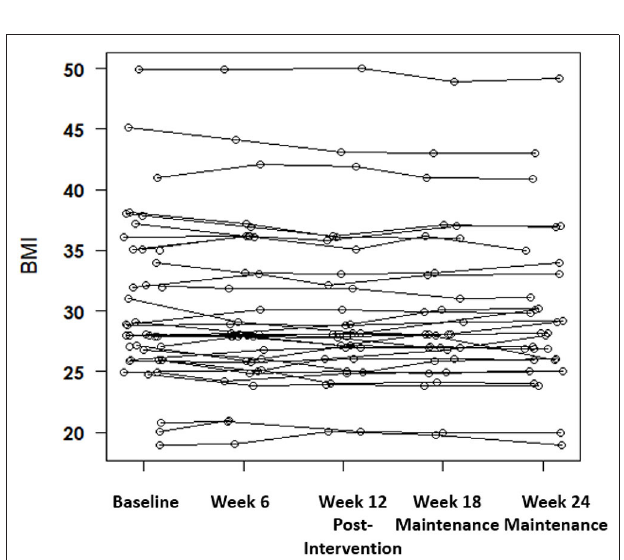
FIGURE 1 | Intervention and maintenance phase BMI measures for a one-arm health coaching intervention with a significant decrease in BMI from baseline to post intervention ( p =